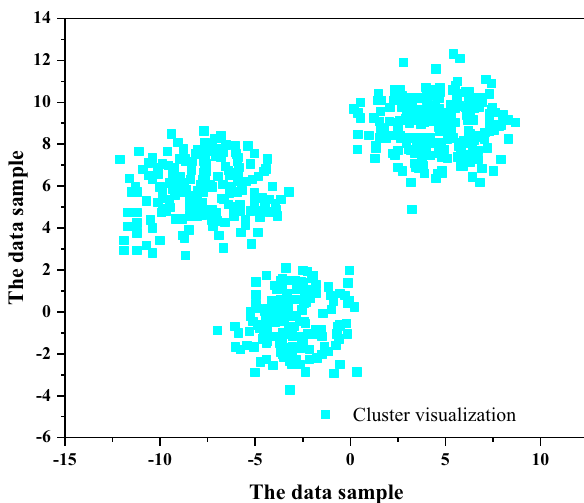
Figure 2: Clustering visualization of data samples when K =